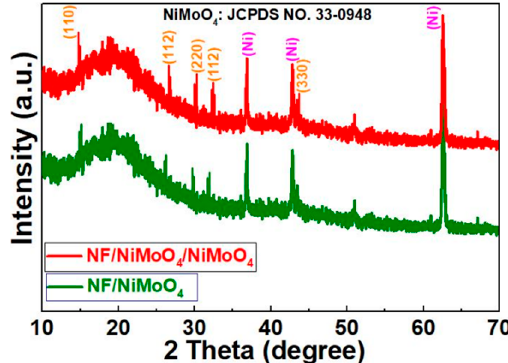
Figure 3. XRD pattern of the fabricated NF/NiMoO 4 electrode and NF/NiMoO 4 /NiMoO 4 composite electrode grown on NF.